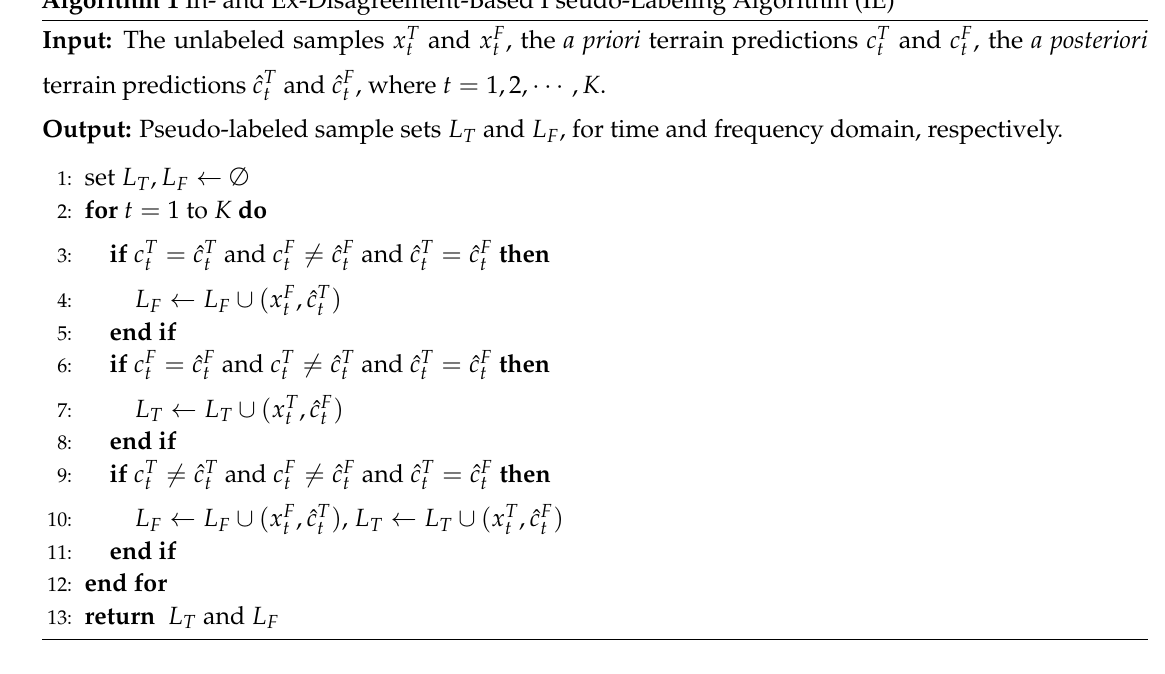
Algorithm 1 In- and Ex-Disagreement-Based Pseudo-Labeling Algorithm